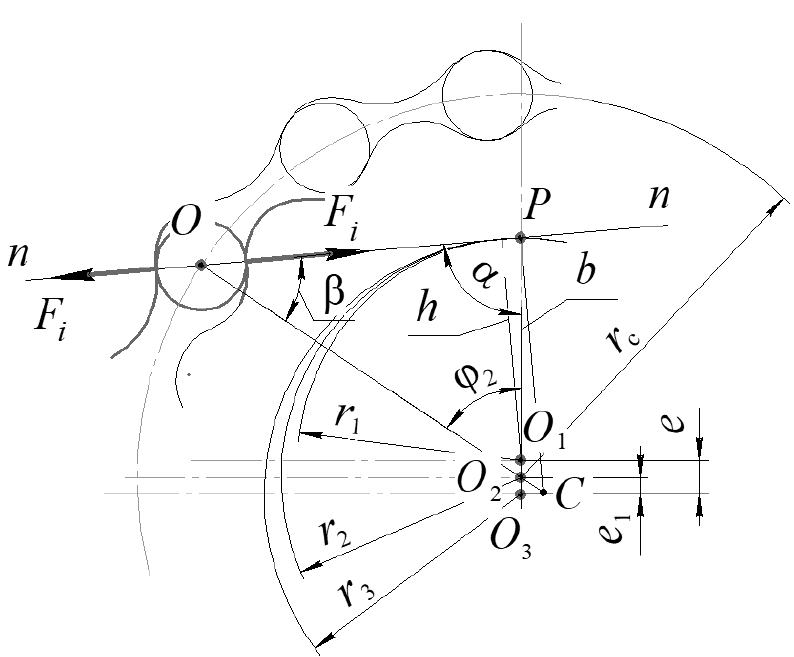
Figure 3. Calculation of forces in the toothing of the transmission with intermediate rolling ele- ments and a free cage. and a free